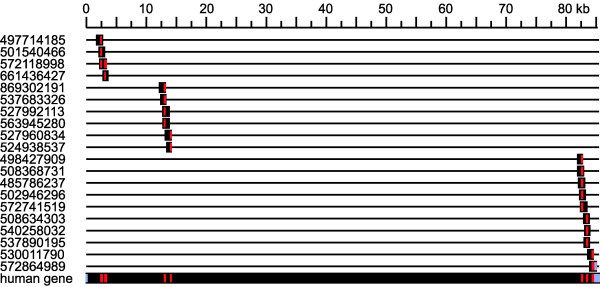
Reconstruction of rhesus macaque coding sequences. Figure shows positions of sequences from the macaque whole genome shotgun trace archive (Macaca mulata WGS) aligned on the human Cernunnos-XLF gene. Coding exons are in red, noncoding parts of exons in blue, introns in black. The numbers on the left correspond to sequence identifiers from the trace archive.